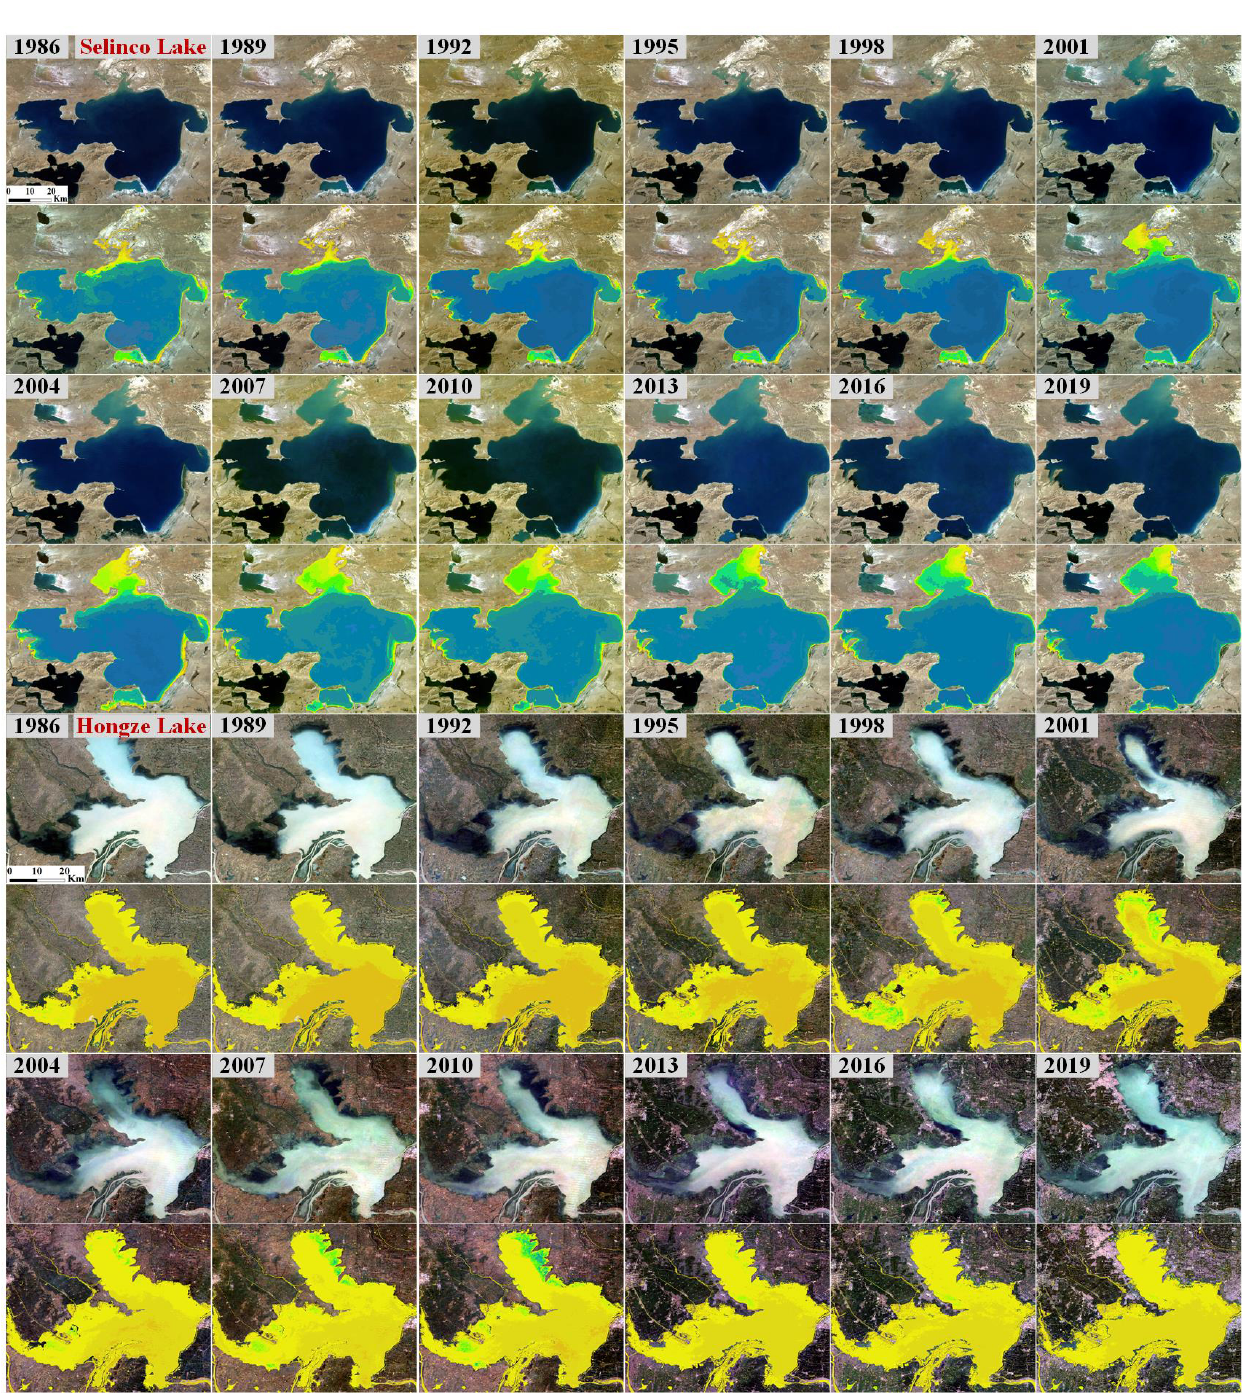
Figure 6. The long-term SD results of Selinco Lake and Hongze Lake between 1985 and 2020. Note: the color bar is the same as that in Fig. 5. The time series background imagery of Selinco Lake and Hongze Lake come from the United States Geological Survey (https: //earthexplorer.usgs.gov/, last access: 10 September